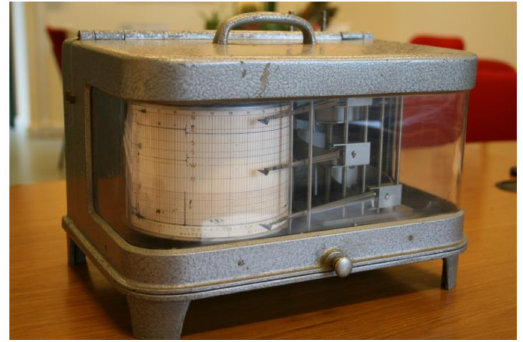
Figure 2. A typical mechanical recorder with paper